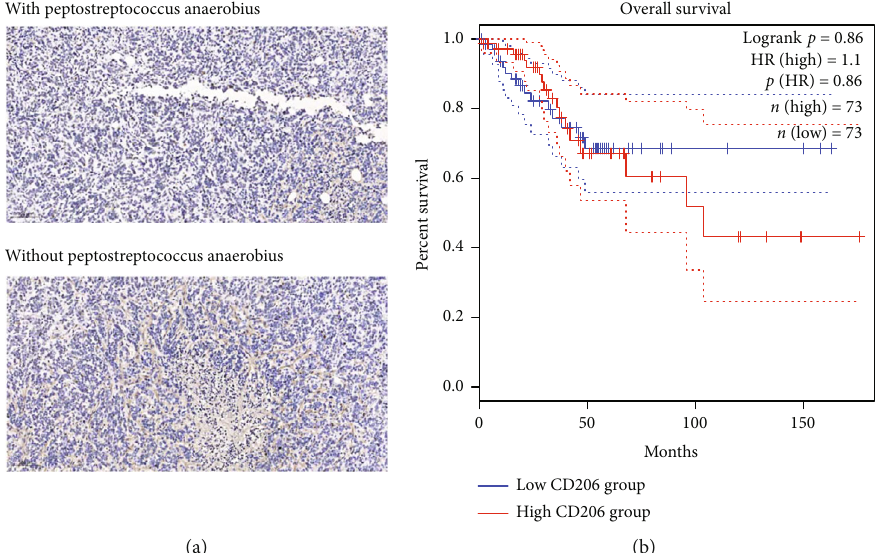
Figure 2: The expression of CD206 in cervical cancer. (a) The IHC staining of cervical carcinoma tissues upon the CD206 in cervical cancer tissues from women with Peptostreptococcus anaerobius (down) and in cervical cancer tissues from women without Peptostreptococcus anaerobius (upper). (b) The analysis of CD206 expression via TCGA set base: the increased expression level of CD206 was relevant to the lower survival rate and inferior prognosis (blue curves); the decreased expression level of CD206 was relevant to the higher survival rate and superior prognosis (red curves).